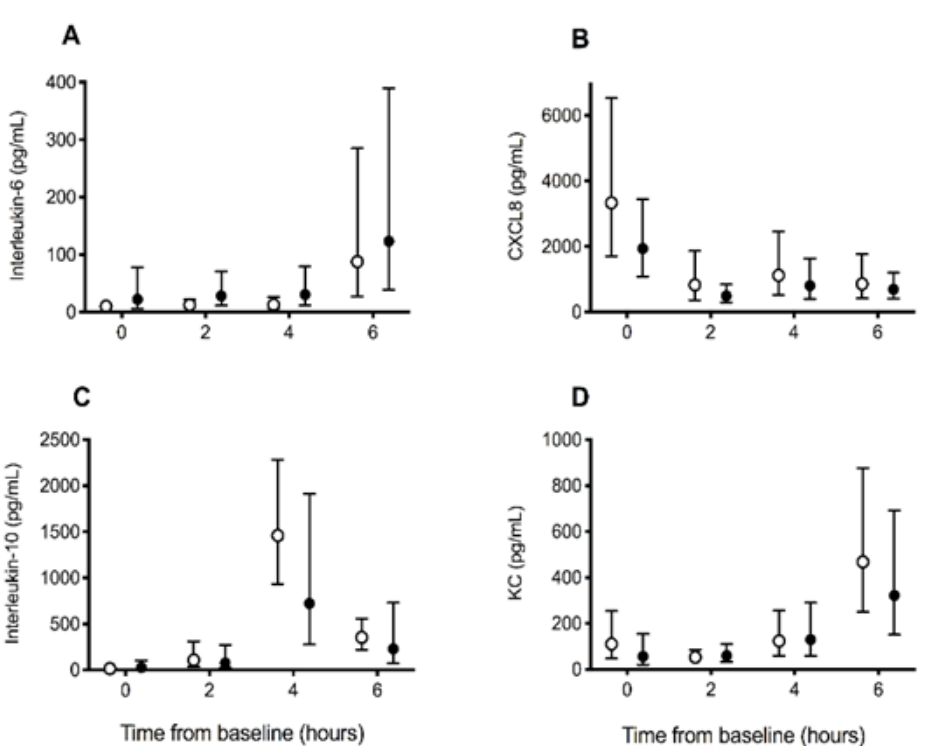
Figure 3. Inflammation biomarker concentrations in dogs receiving saline (control) or deferoxamine (treatment) at baseline and 2 hourly intervals after atraumatic hemorrhage and allogenic red blood cell transfusion. Means (95% CI) of ( A ) interleukin-6, ( B ) CXC motif chemokine-8 (CXCL8), ( C ) interleukin-10, and ( D ) keratinocyte-derived chemokine (KC) in dogs receiving saline (control: ○ , n = 10) or deferoxamine (treatment: ● , n = 10). Between baseline and 2 h, all dogs had 900 mL of whole blood removed, had 15 mL/kg of allogenic, stored, packed red blood cells transfused over 20 min, and then received 20 mL of saline (control) or an equal volume of 13.3 mg/kg deferoxamine in saline (treatment) as a continuous intravenous infusion lasting 55 min.